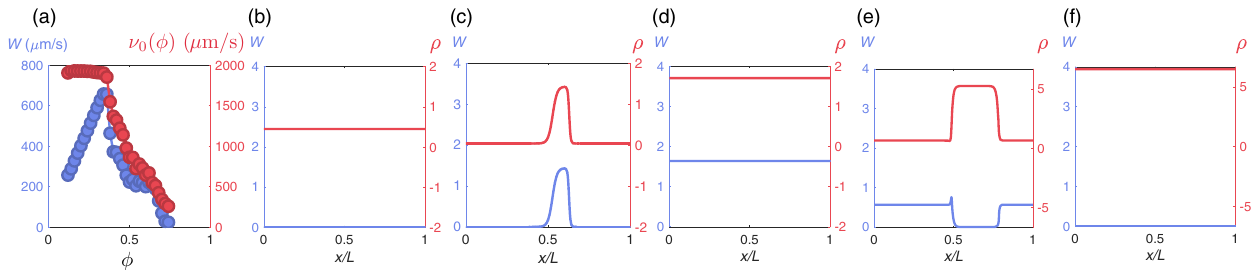
FIG. 4. Nonlinear hydrodynamics of polar active matter. (a) Average velocity ν 0 ð r ; t Þ of the colloids and local magnitude of the longitudinal current W ð r ; t Þ plotted as a function of the local packing fraction ϕ ð r ; t Þ . (b) – (e) Successive phases observed in the resolution of Eqs. (1) and (2) at increasing average densities ρ 0 ¼ ð 0 . 10 ; 0 . 18 ; 1 . 7 ; 1 . 96 ; 6 . 5 Þ . The position x is normalized by the system 1 , λ ¼ 1 , a 0 . 45 , σ ¼ 0 . 2 , ¯ ρ ¼ 2 , ξ ¼ 0 . 01 , α ¼ 1 , ρ 0 . 5 , L ¼ 200 , size L . Simulation parameters are D ρ ¼ 0 . 2 , D 4 ¼ W ¼ c ¼ dx ¼ 0 . 05 , dt ¼ 0 . 005